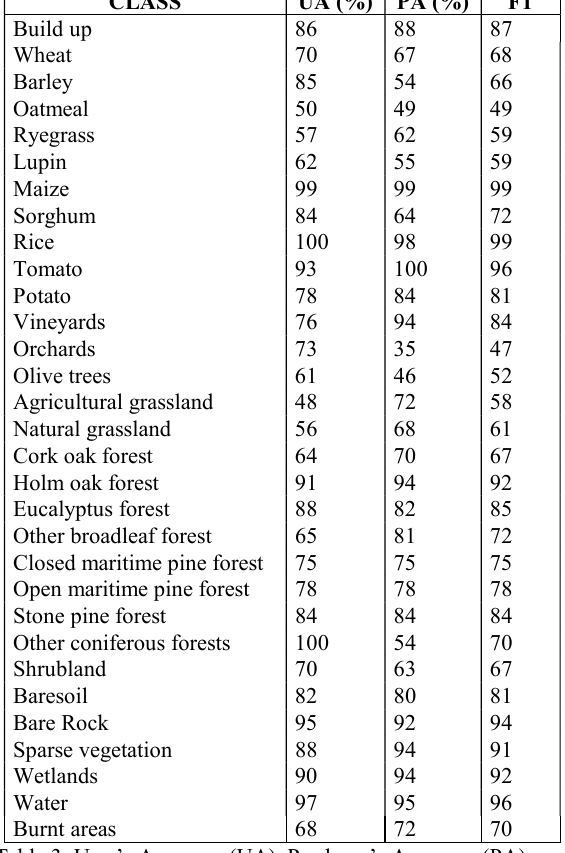
Table 3. User’s Accuracy (UA), Producer’s Accuracy (PA), and F1-Score of the map